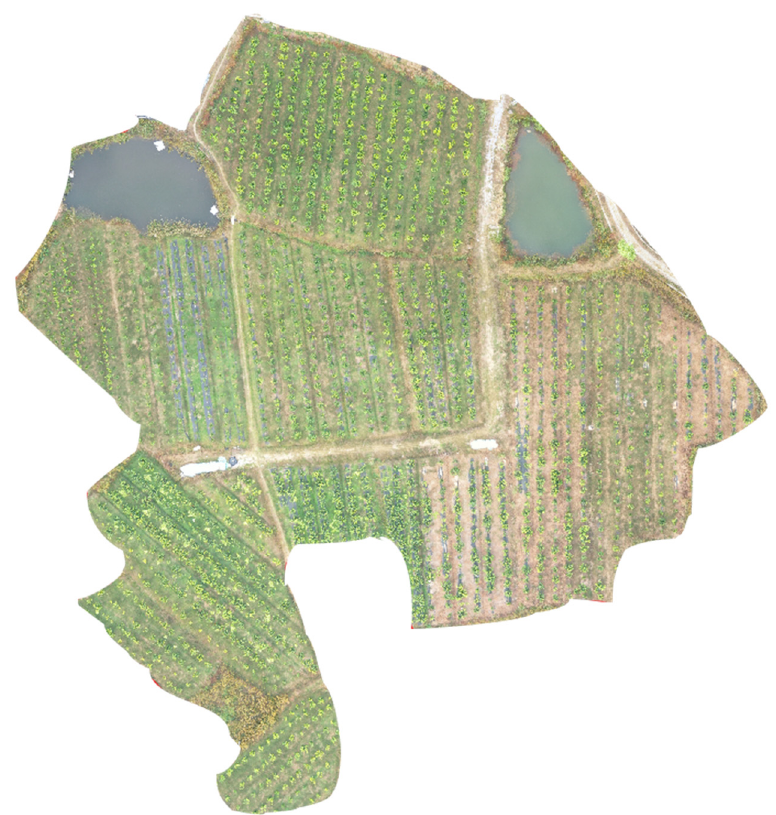
Figure 1. Cropped orthophoto of the study area.